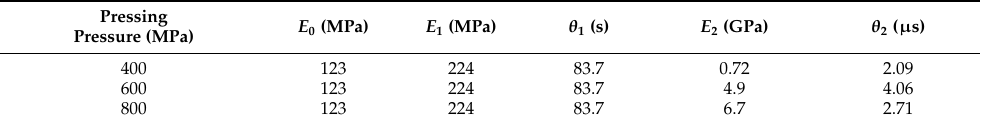
Figure 16. Comparison of the fitting results of the ZWT constitutive model with the experimental results under 800 MPa pressing pressure and different strain rates: ( a ) 1400 s − 1 ; ( b ) 2600 s − 1 . The parameters of the ZWT constitutive model obtained by different pressing pressures have been determined, and the parameters are listed in Table 4. Table 4. Constitutive model parameters of the reinforced Al/PTFE prepared by different pressing pressures.